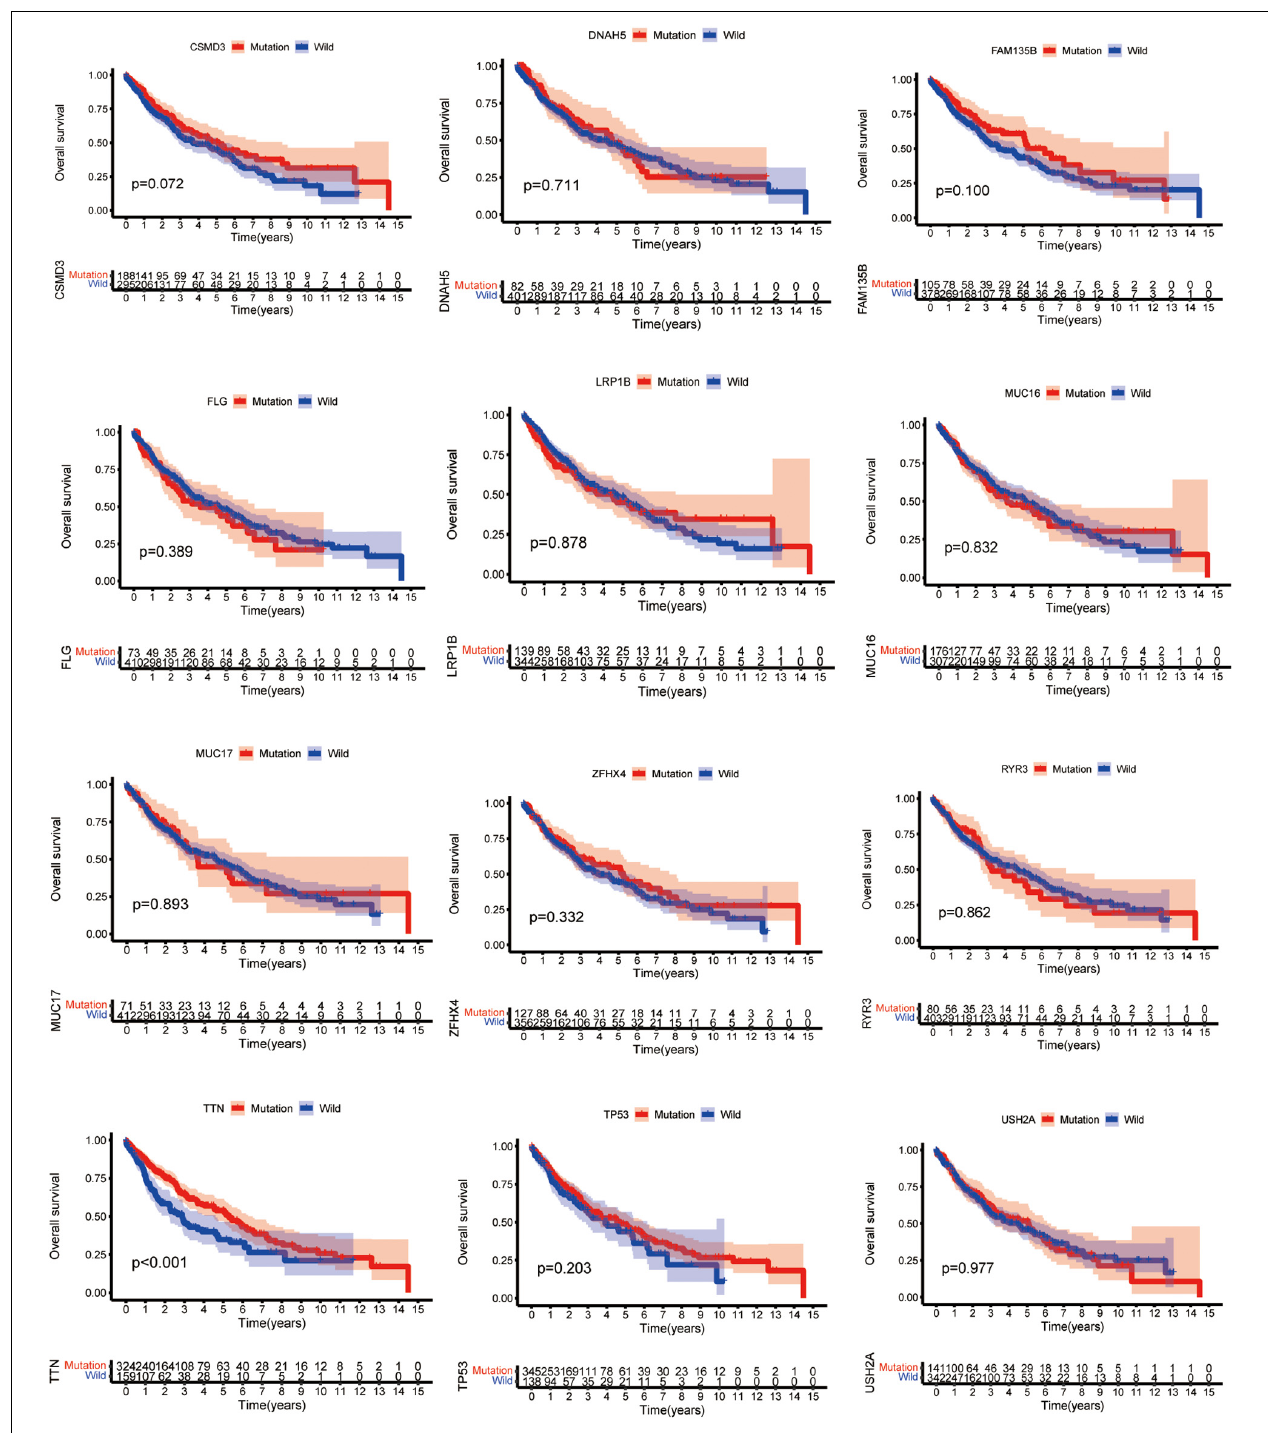
FIGURE 3 | TTN mutation is associated with clinical prognosis. The Kaplan–Meier survival study was adopted to determine survival curves reflecting the relationship between mutant genes and prognostic results. The p -value is shown in every illustration.